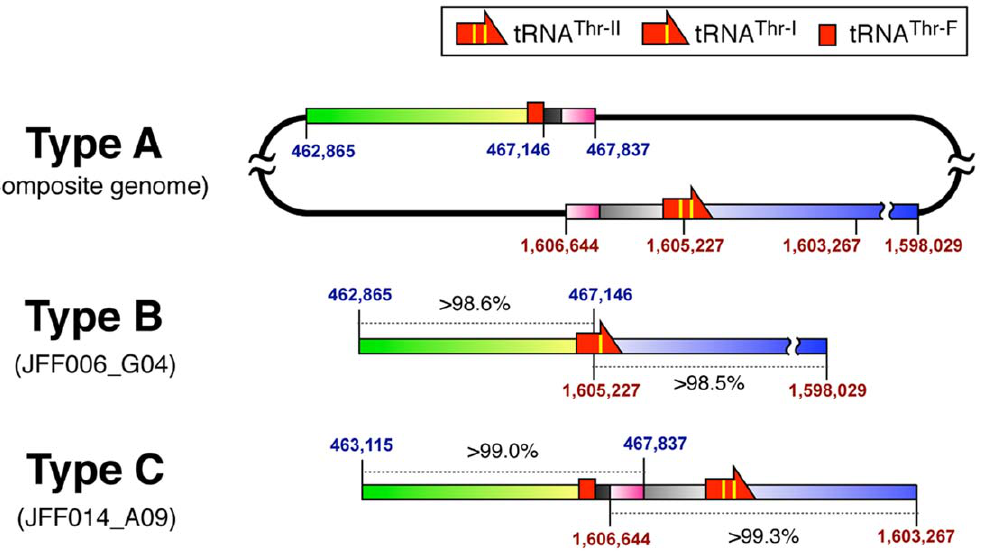
Figure 2. Genomic heterogeneity in tRNA Thr (GGU) gene loci in the composite genome and cloned sequences. Schematic representation of the composite genome of C. subterraneum and the nucleotide sequences of clones JFF006_G04 and JFF014_A09 are shown (types A, B, and C, respectively). Homologous regions between the composite genome and the cloned sequences are shown in the same colors, and the similarity scores (%) against the corresponding regions in the composite genome are indicated on the cloned sequences. The genomic positions of the two distantly located regions in the composite genome are shown as red and blue numbers.